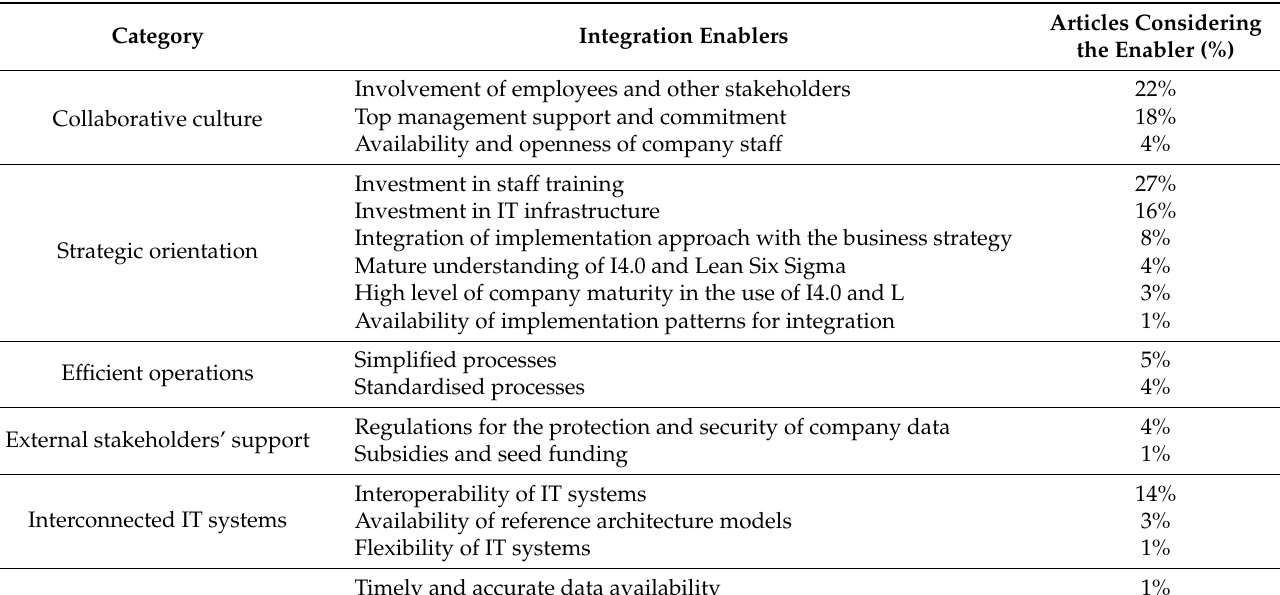
Table 3. I4.0 and LSS integration